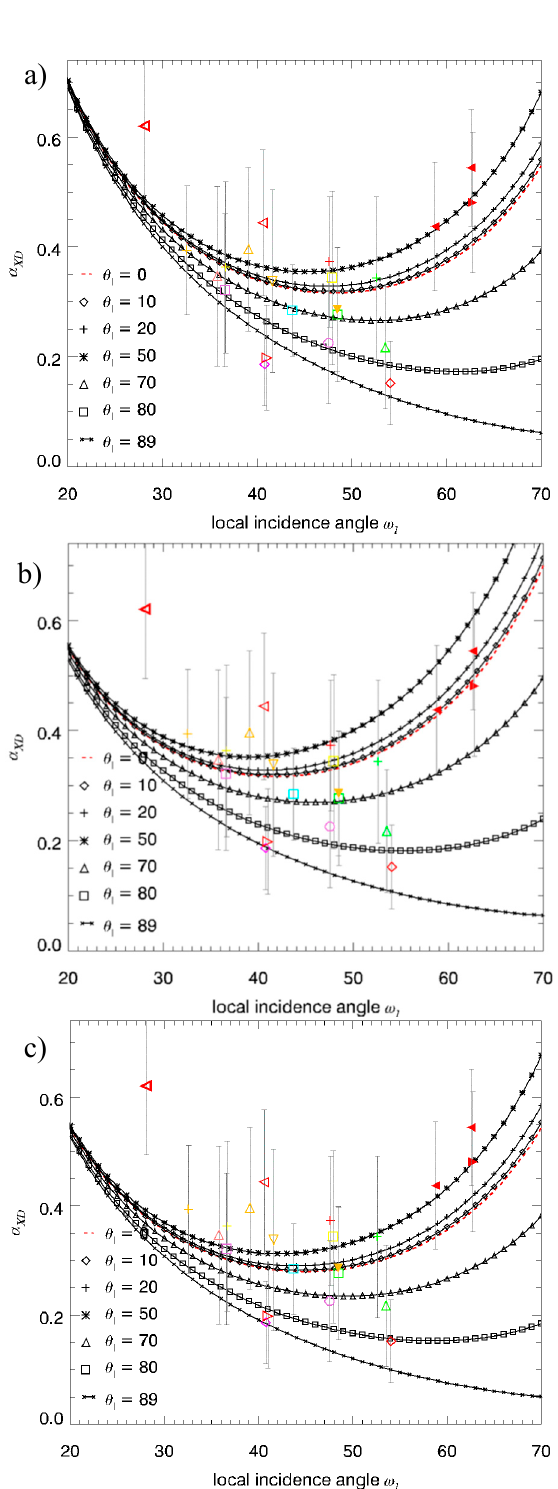
Figure 28. Comparison of α XD from extended Fresnel scattering (black lines) and from standard Fresnel scattering (red dashed line) along the local incidence angle ω l ; α XD is derived from the X-Fresnel model ( ε s = 25, ε t = 15, ϕ = 0° ( a ); ε s = 15, ε t = 25, ϕ = 0° ( b ); ε s = 25, ε t = 25; ϕ = 0° ( c )) for different roughness angles θ 1 and from the AgriSAR (plus (June) and triangle up (July) sign), OPAQUE (square sign), SARTEO (diamond sign) and TERENO (triangle down = Bode site, triangle right Demmin site E-W track, triangle left Demmin site N-S track) L-band data for several agricultural fields with a stalk-dominated phenology (yellow = winter barley, green = field grass, gold = winter wheat, pink = winter wheat (field 221), cyan = grassland, red = undefined land use, orchid = winter triticale); gray bars indicate the standard deviation of α XD for each of the agricultural fields.